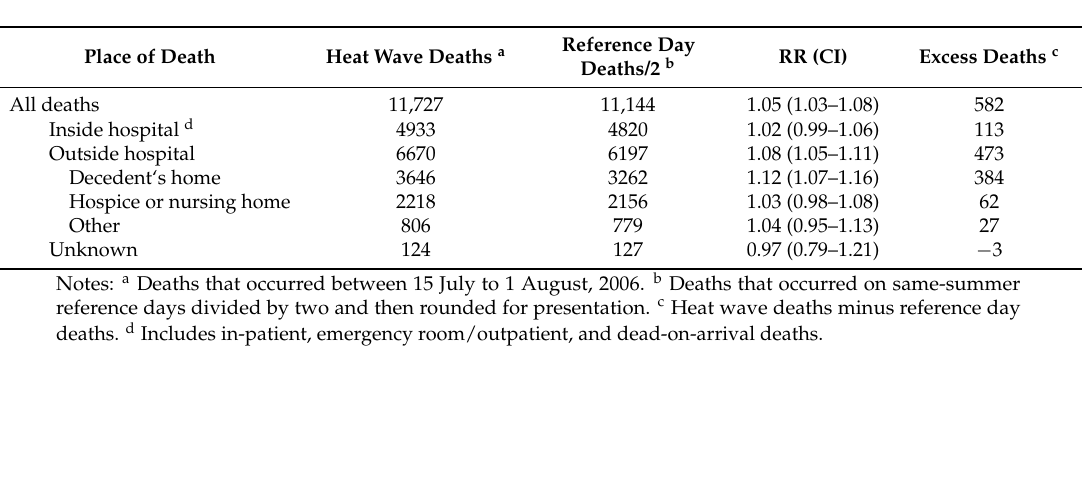
Table 1. Heat wave mortality relative risks (RR), 95% confidence intervals (CI), and excess deaths by place of